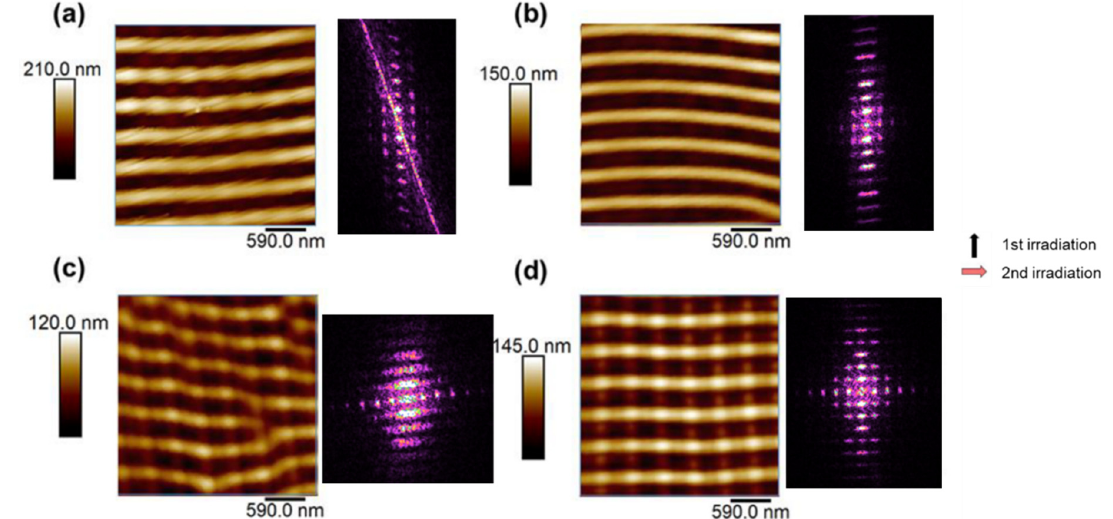
Figure 3. AFM images of combined LIPSS formed by sequential irradiation in P3HT at λ = 532 nm by varying the number of pulses of each irradiation: ( a ) 1800 + 1800 pulses, ( b ) 2400 +1200 pulses, ( c ) 3000 + 600 pulses and ( d ) 3300 + 300 pulses. In the right column, the Fourier Transform of each image is shown. Arrows indicate the direction of the laser polarization during each irradiation step.